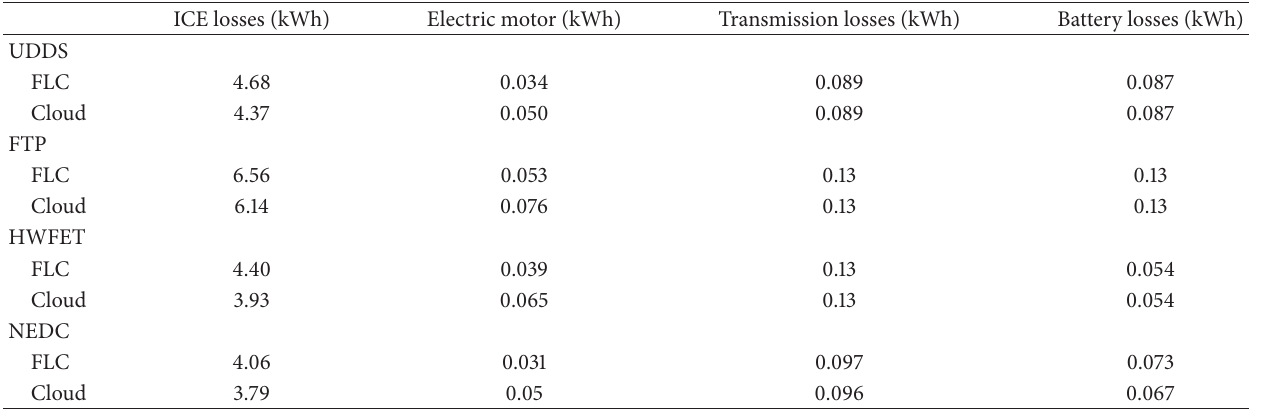
Table 2: Comparison of component losses for two controllers for four driving